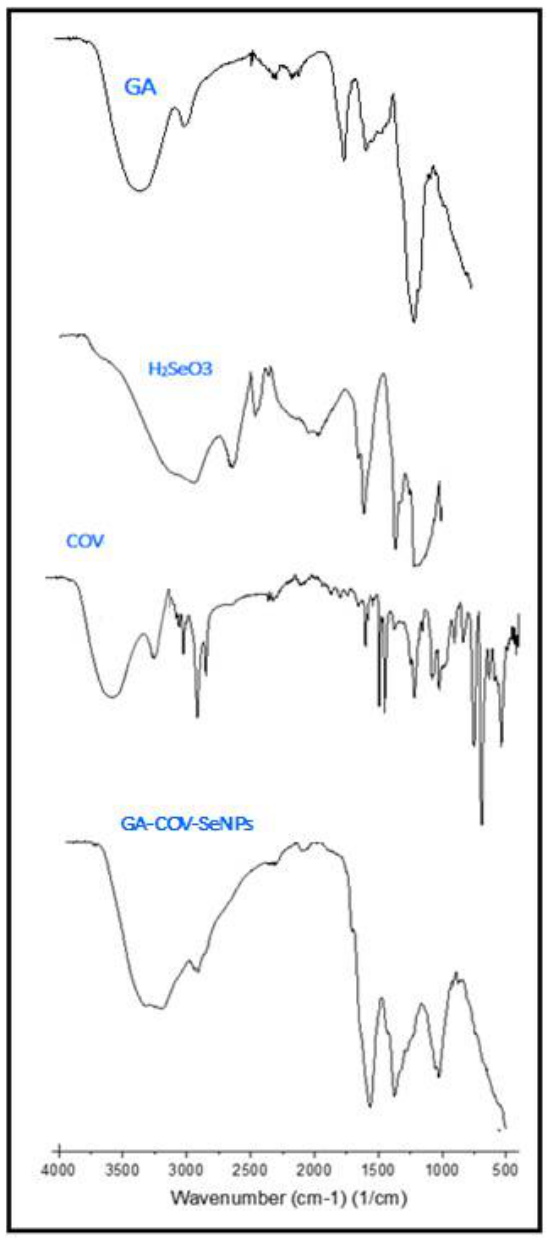
Figure 5. FTIR spectra of GA, H 2 Se 2 O 3 , COO, and